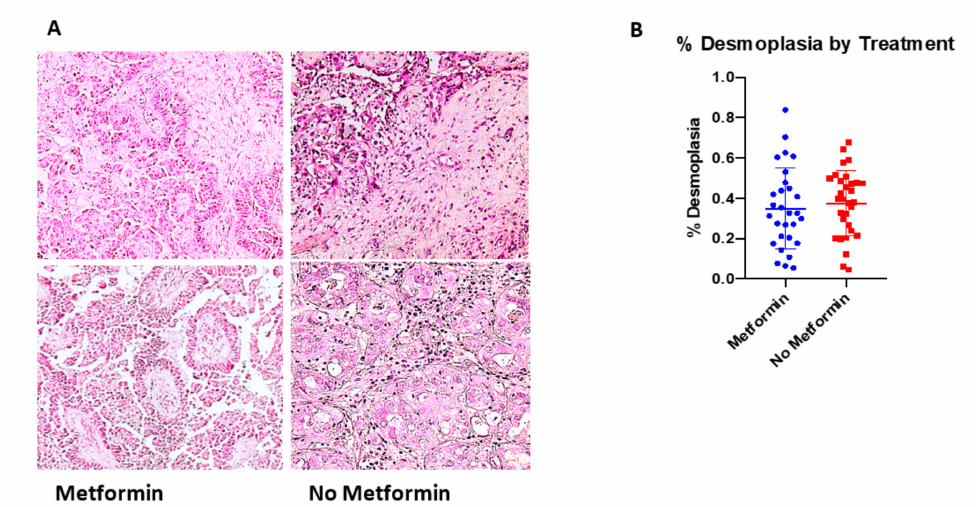
Figure 2. Amount of desmoplasia did not differ with addition of metformin to standard chemotherapy (control). ( A ) Representative light microscopy images of H&E stained tumor tissue from metformin- treated and non-metformin-treated human samples (10 × ). ( B ) Quantification of desmoplasia amount for available tissue samples. Desmoplasia reported as a percentage of the total tissue